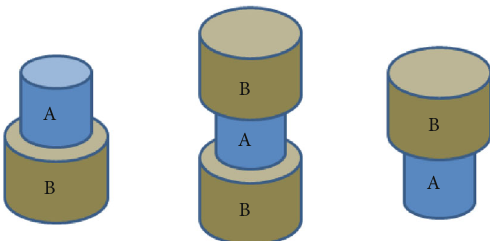
Figure 4: Nonsame diameter coal-rock combined body model.